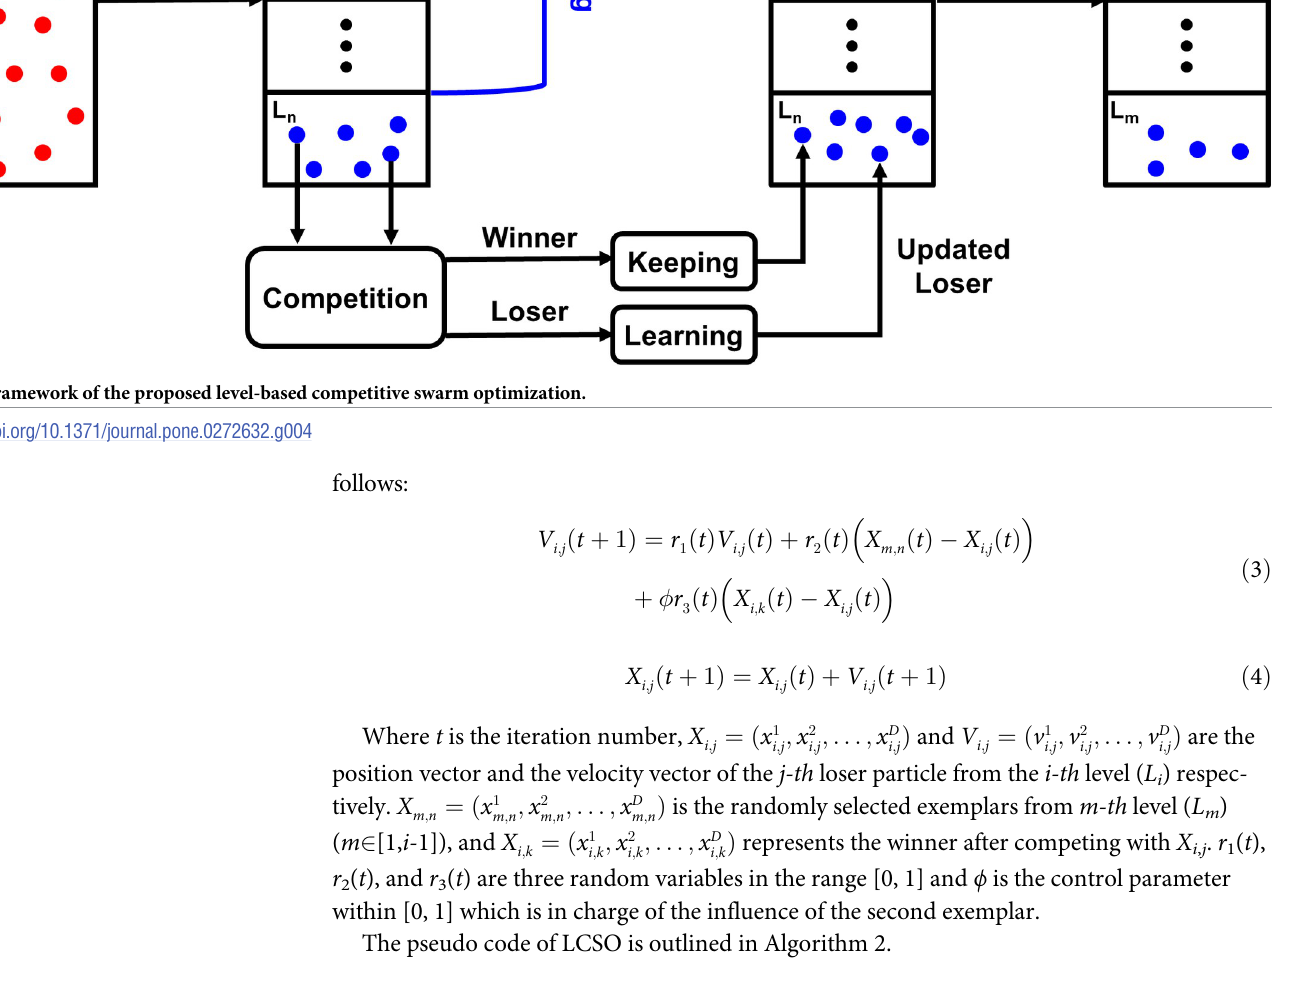
Algorithm 2: Framework of LCSO